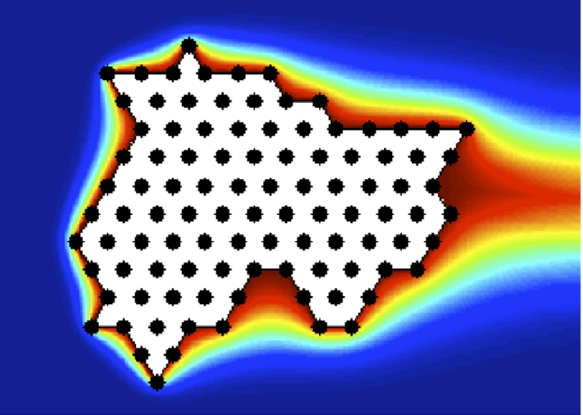
Figure 1. Sample of a computed temperature. Temperature distribution around a huddle of 100 penguins, for Pe ~ 100 . Here red and blue correspond to warmer and cooler temperatures, respectively. Individual penguins are shown in black, as is the boundary of the huddle, while the polygonal interior of the huddle is shown in white. We show an initial configuration where penguins have yet to be relocated.